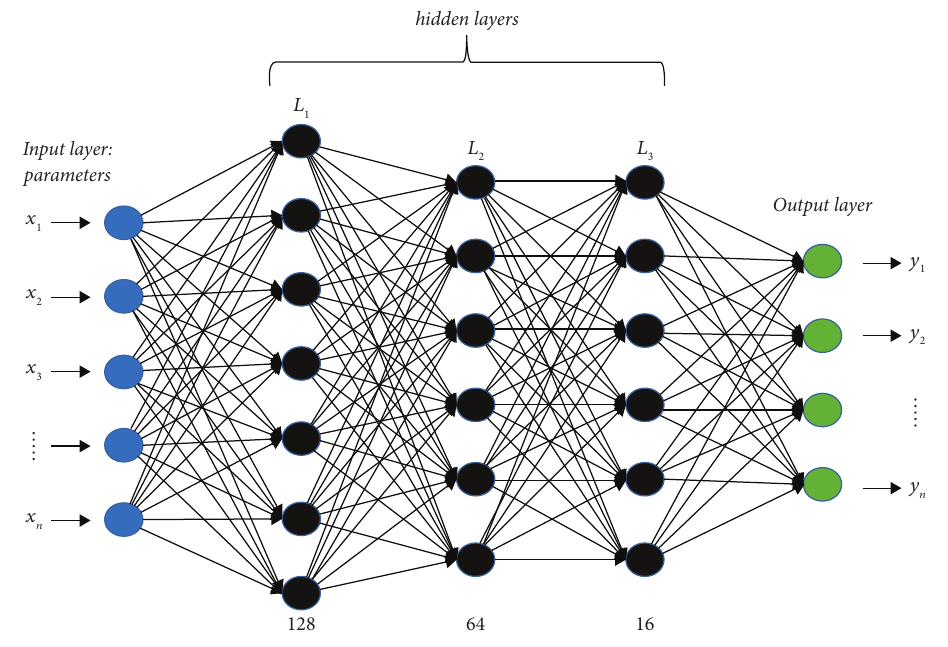
Figure 4: Deep learning architecture. Table 4: Details of the trained deep learning